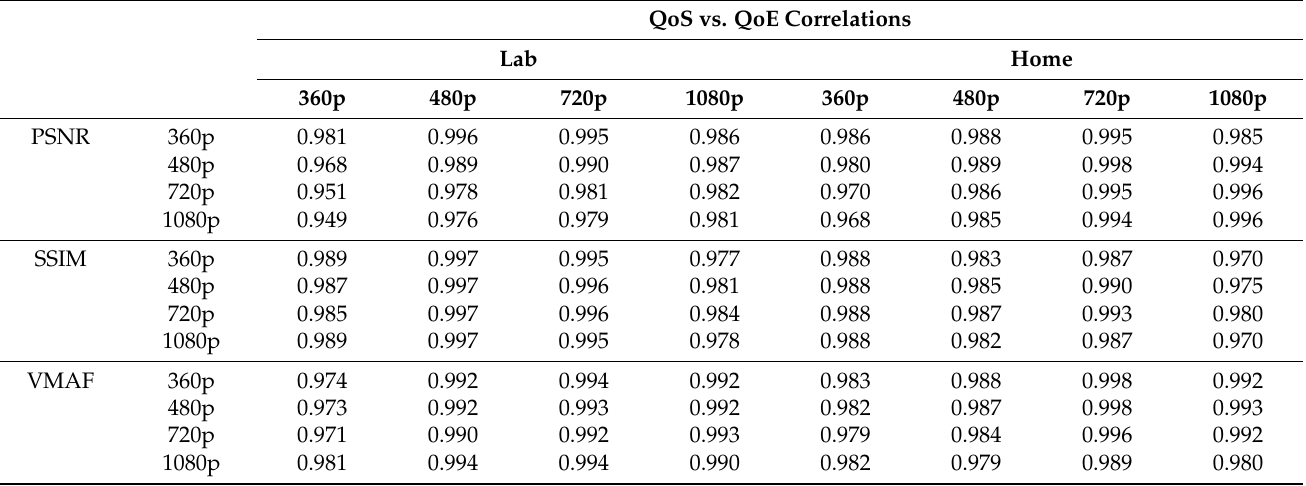
Table 10. Correlations between QoS and QoE values (in the lab and home) for H.264 encoded video. QoS vs. QoE Correlations Lab Home